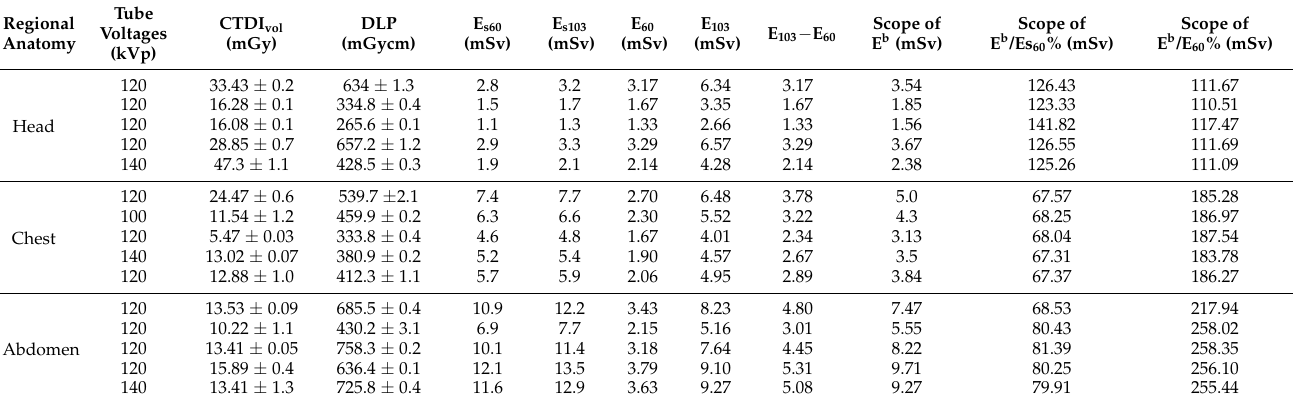
Table 4. Effective dose (E d ) using organ dose-based estimates and comparison for ICRP 60, 103 and Monte